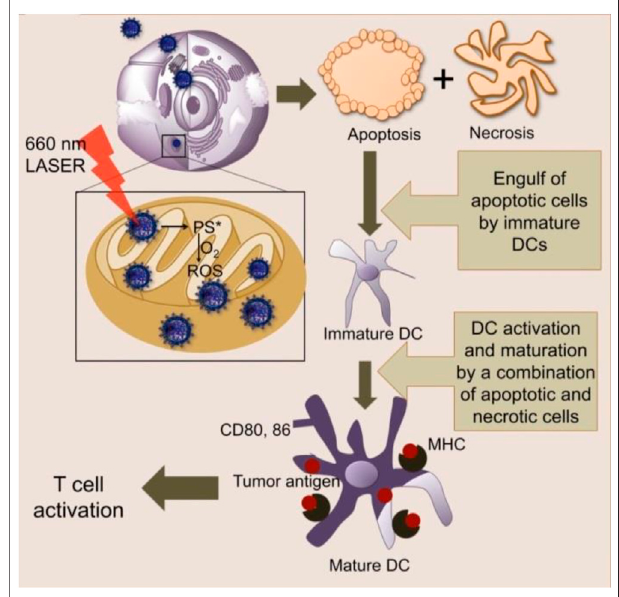
FIGURE 7 | Mitochondria-targeted NPs act upon light activation inside the mitochondria to produce ROS and cause cell death via apoptosis and necrosis (Marrache et al.,